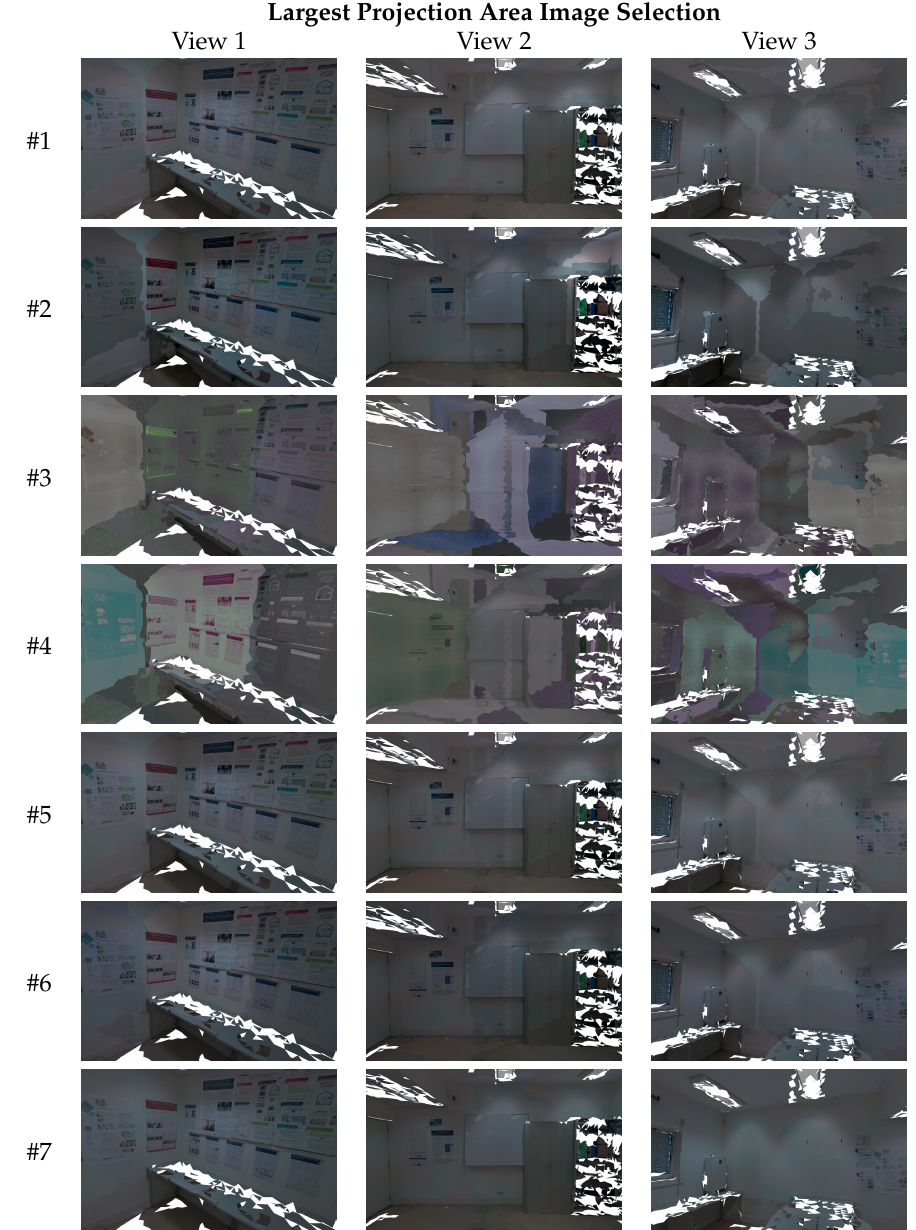
Figure 13. Mesh-based qualitative evaluation: textured meshes produced by each approach (rows) from three different viewpoints, and using the largest projection area image selection technique